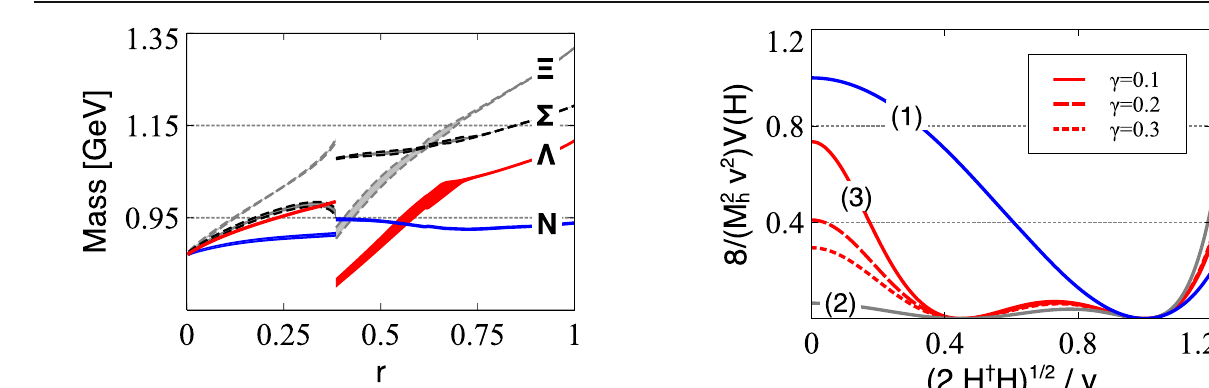
Fig. 2 A Higgs potential with two local minima as introduced in (2) and (3). It is compared with the tree-level potential of the SM